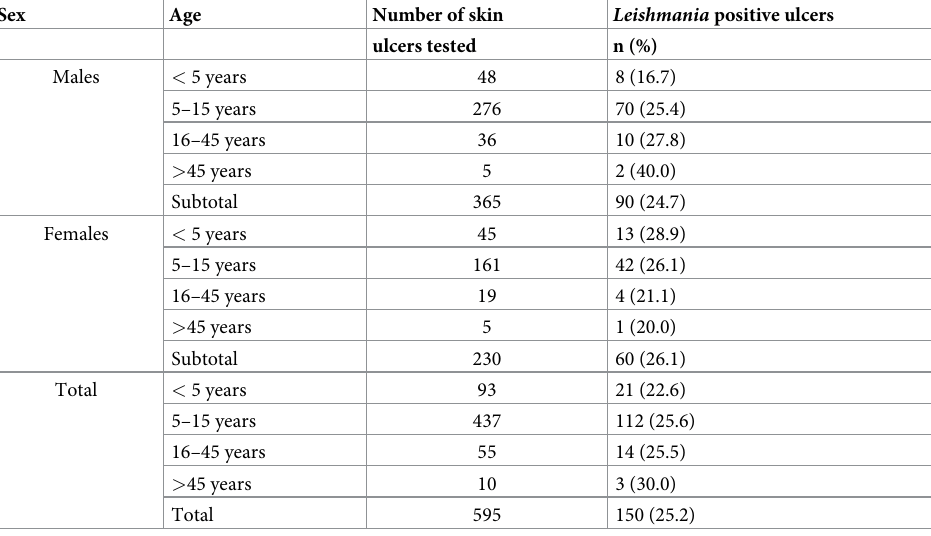
Table 2. Skin ulcers tested for Leishmania parasite using PCR by age and sex.